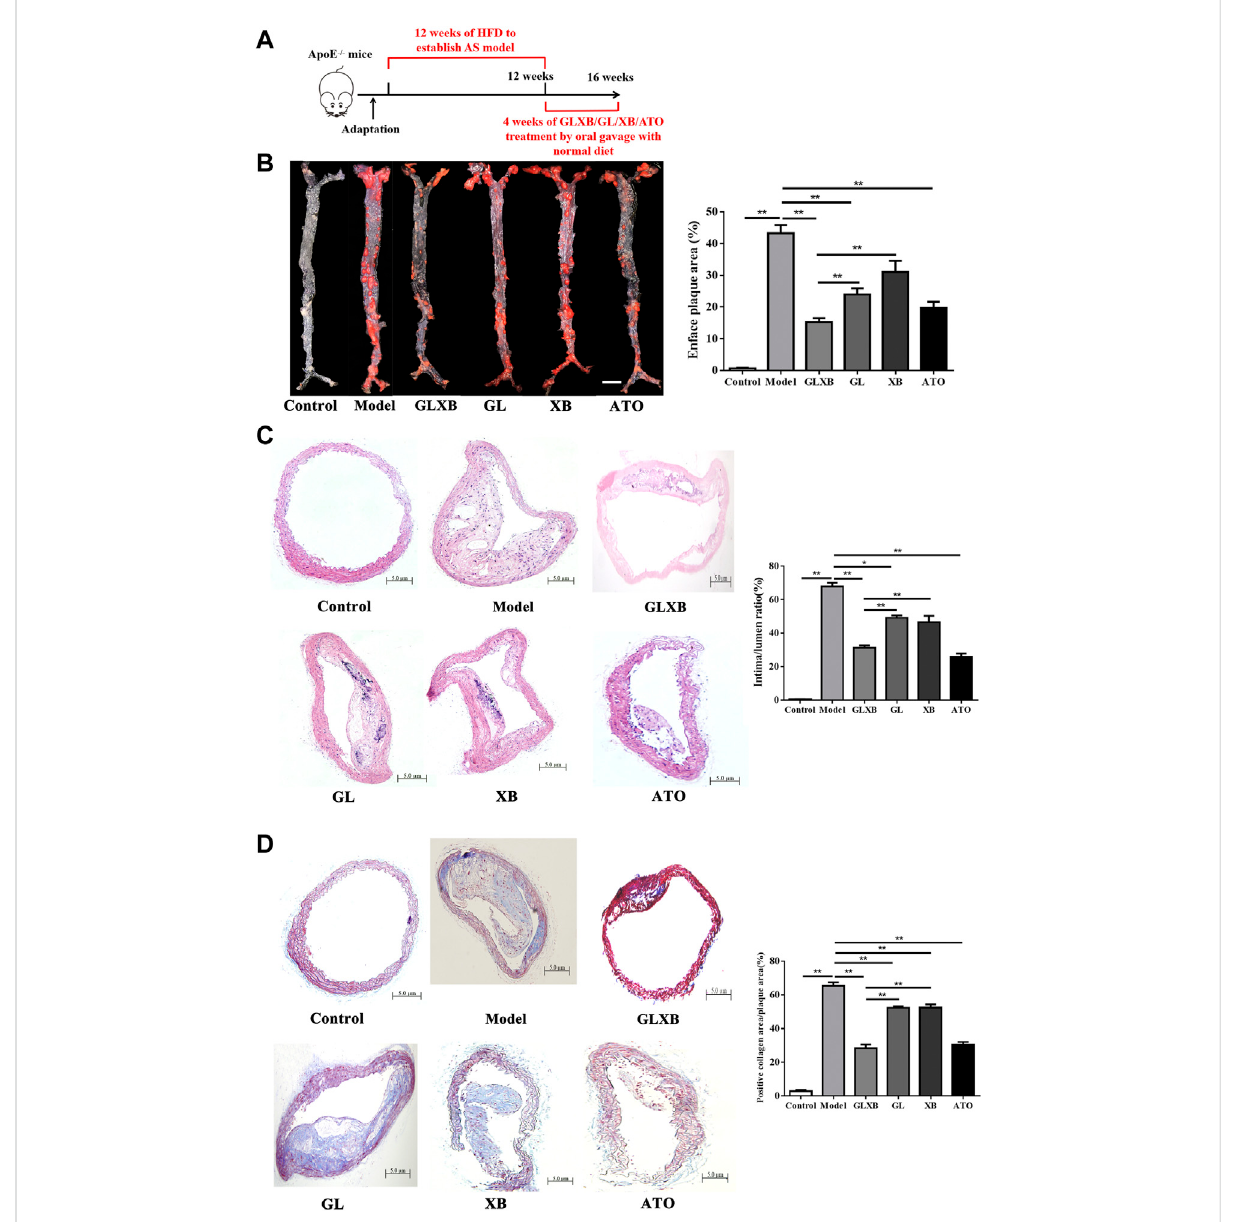
FIGURE 1 Thesynergeticanti-atheroscleroticeffectsofGLXBherbpair. (A) Studydesignof invivo experiment. (B) Enface oil-redO(ORO)stainingonthe whole aorta of mice and quanti fi cation of plaque areas. Bar = 3 mm. (n = 3). (C) HE staining on aortic arch and quanti fi cation of plaque areas. Bar = 500 μ m. (n = 6). (D) Masson staining on aortic arch and quanti fi cation of plaque areas. Bar = 500 μ m. (n = 6). Data were expressed as mean ± SEM. * p < 0.05, ** p < 0.01. GLXB: Gualou – Xiebai herb pair (6 g/kg); GL: Gualou (4 g/kg); XB: Xiebai (2 g/kg); ATO: Atorvastatin (10